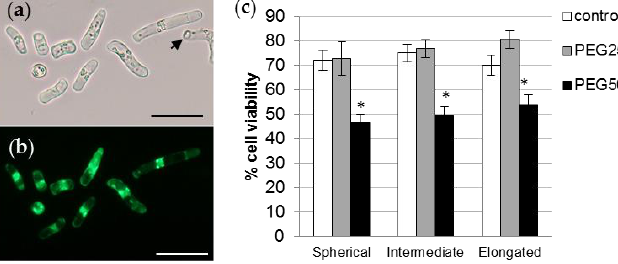
Figure 6. Viability of P. nigra root AC-DCs. Isolated AC-DCs from control seedlings were observed under bright field ( a ) and fluorescence ( b ) after staining with the FDA probe. The arrow shows a non-fluorescent dead cell. Bar scale: 50 μ m. ( c ) Percentage of viability of the different AC-DCs morphotypes after 72 h under control and stress conditions (mean and standard error of 12 roots from 4 biological replicates, with a minimum of 100 AC-DCs per root). * indicates significant difference with the corresponding control at level alpha = 0.05 according to a Kruskal–Wallis test with Dunn’s procedure.